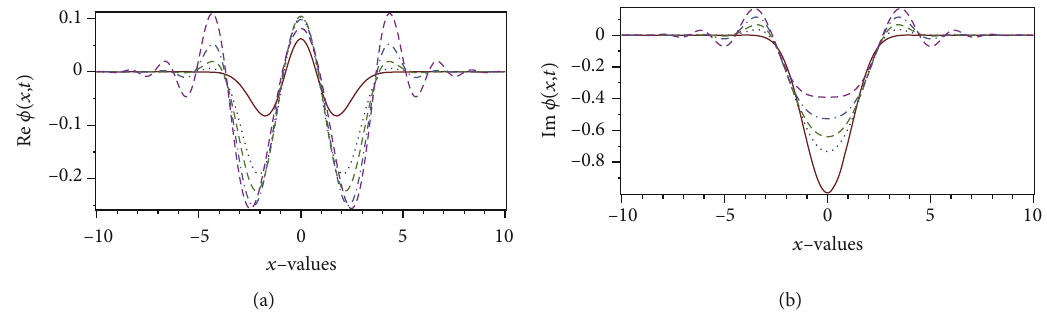
Figure 3: Real and imaginary parts of solution of (73) for a = b = c = 1, k = 1/2, t = 1/2, t = 2, t = 3, t = 5, t = 10, and f ð x Þ = e − ð 1/2 Þ x 2 .